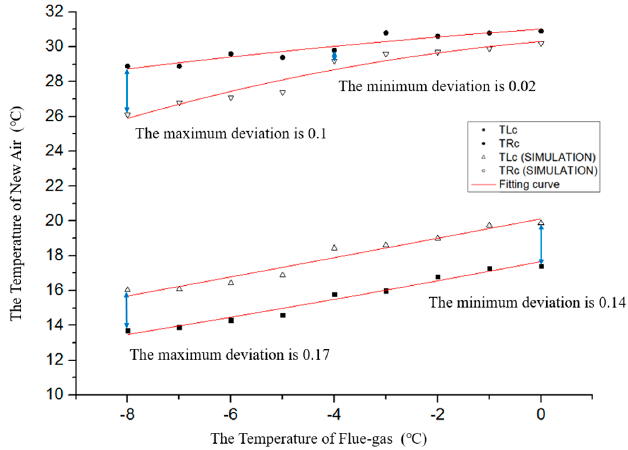
Figure 12. Comparison of the simulated and measured temperature.